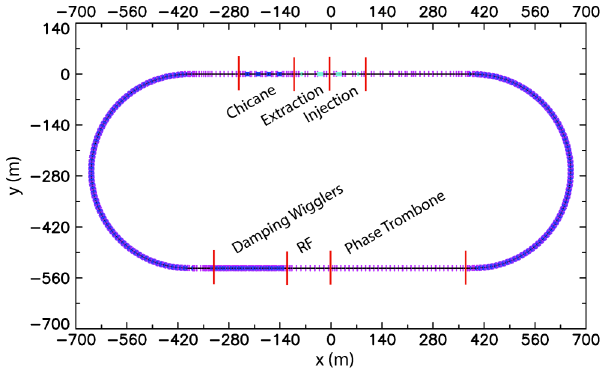
and β , and the a b in the DTC04 arc x